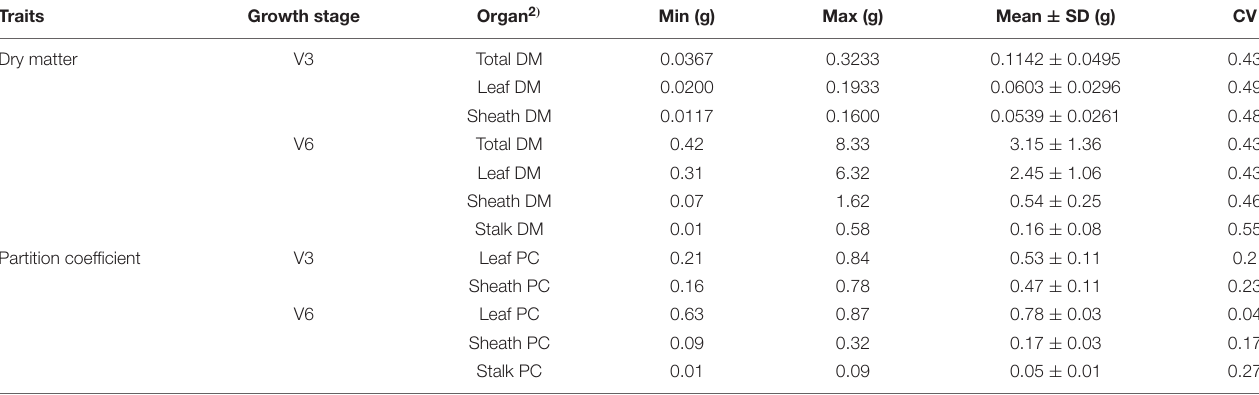
TABLE 1 | Descriptive statistical analysis of dry matter-related traits in this study 1 ) . Traits